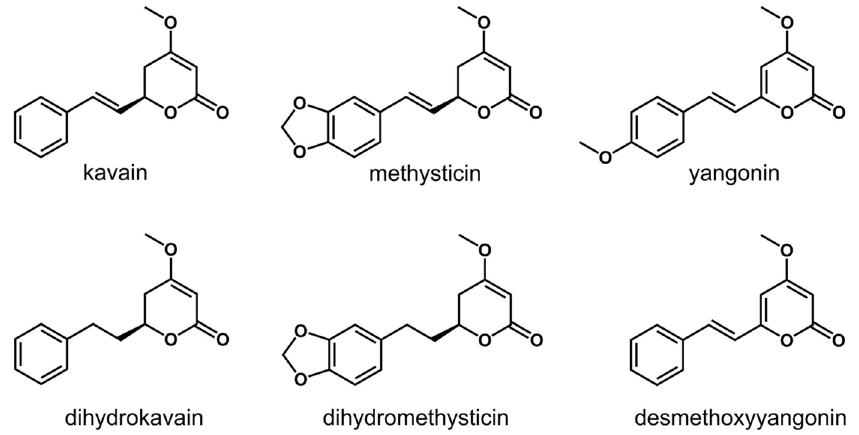
Fig 1. Chemical structures of the six major kavalactones found in